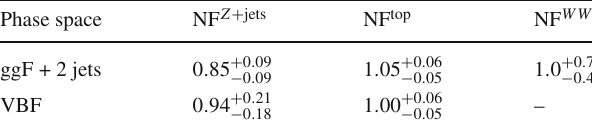
Table 5 Post-fit NFs and their uncertainties for the Z + jets, top and WW backgrounds. Both sets of normalisation factors differ slightly depending on which (B)SM model is tested, but are consistent within their total